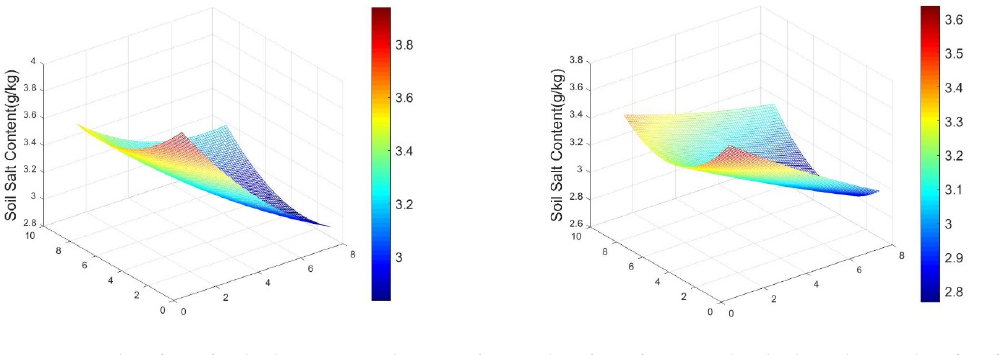
Figure 5. Soil salinity trend surface of test area A.